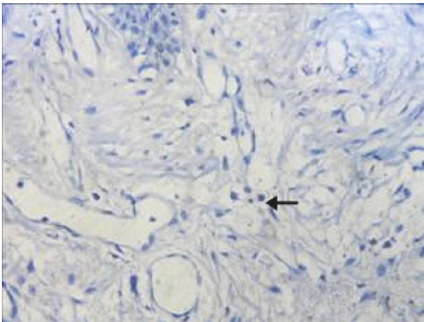
Figure 6: Photomicrograph of the section shows intact mast cells in oral lichenoid reaction (H&E 40x). The arrow refers to intact mast cells.